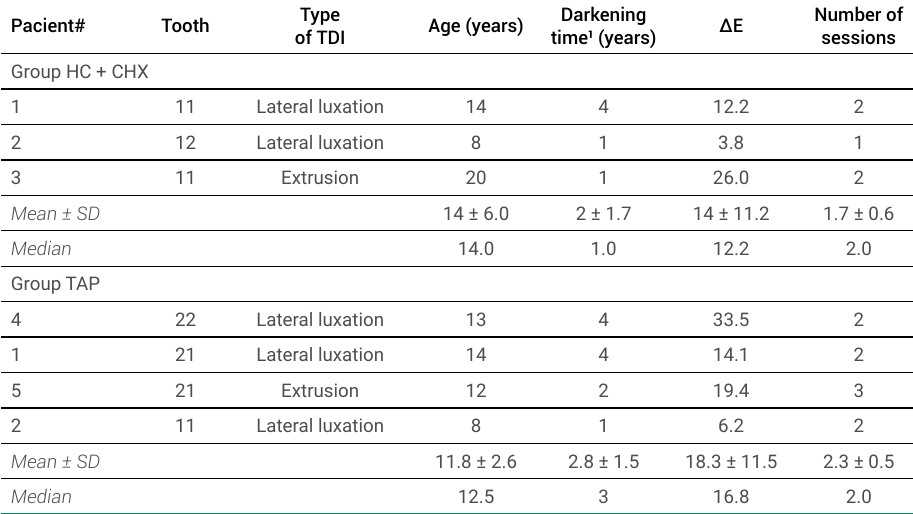
Table 1. Main characteristics of the cases.